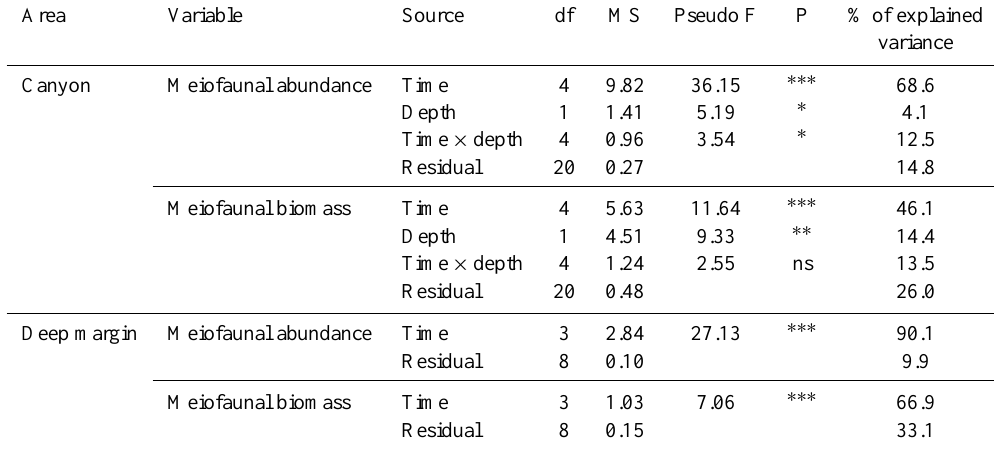
Table 3. Results of the PERMANOVA tests on the abundance and biomass of meiofauna in the sediments of the Cap de Creus Canyon and deep margin. Also reported is the percentage of variance explained by each source of variation and their interaction. df = degrees of